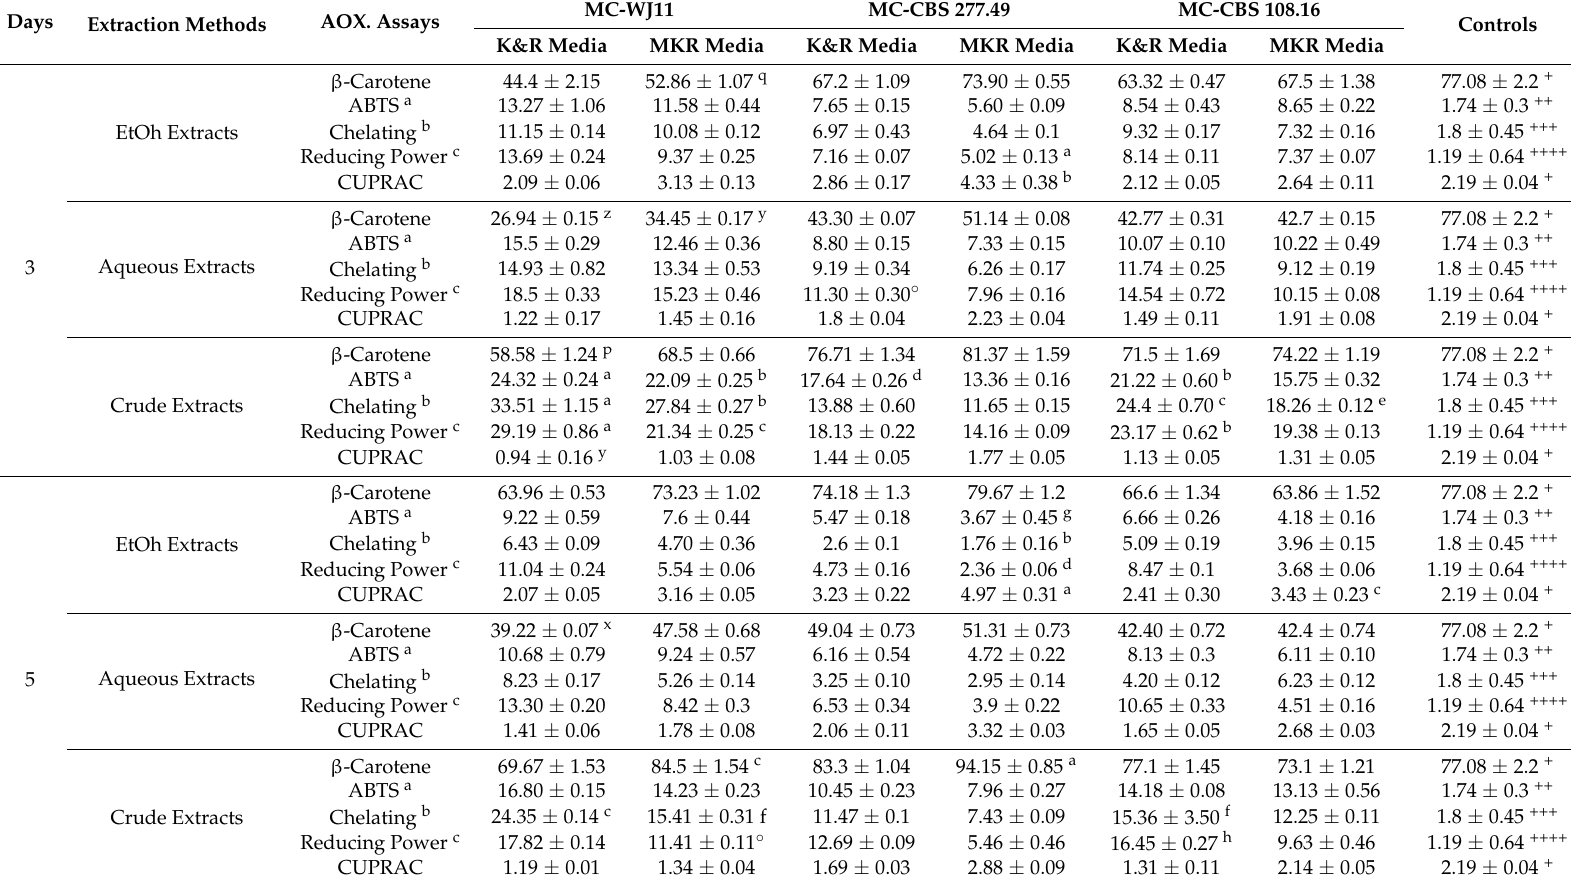
Table 3. Summary of antioxidant assays of three types of fungal mycelia extracts grown on two kinds of media and harvested at different growth phases.